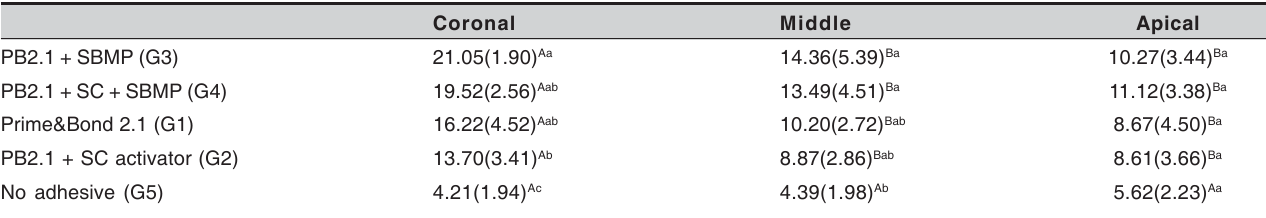
Table 1 - Push-out bond strength values in MPa (SD) for the different luting procedures at the three root canal thirds